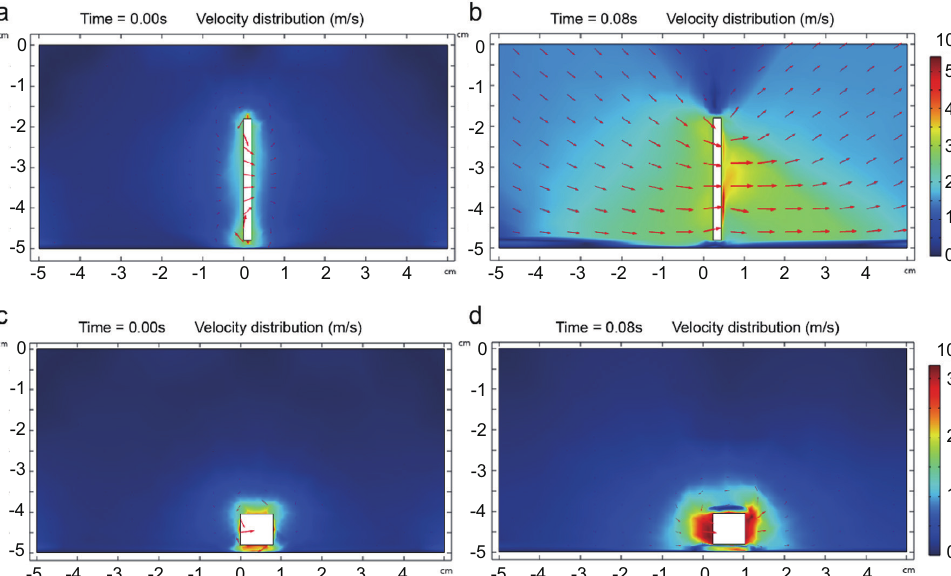
Figure 12. Simulation results of flow induction by the MHCMM. ( a ) The initial state (at 0 s) of the millirobot with the string structure is denoted by the slender square. ( b ) At 0.08 s, the slender square moves with a velocity of 3.0 cm/s. In the simulation, the total areas of the slender square and the flat square are identical. ( c ) The initial state (at 0 s) of the millirobot with normal structures, which are denoted by flat squares. ( d ) At 0.08 s, the squares move with a velocity of 3.0 cm/s.